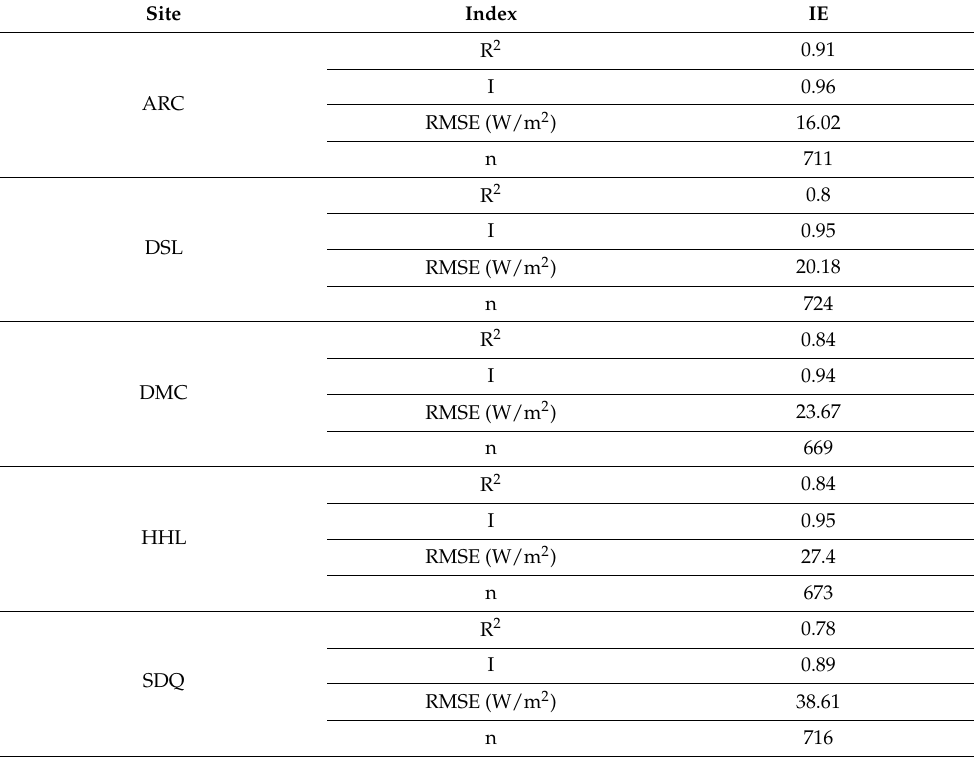
Table A1. Model performance statistics with daily mean data in the five typical ecosystems.